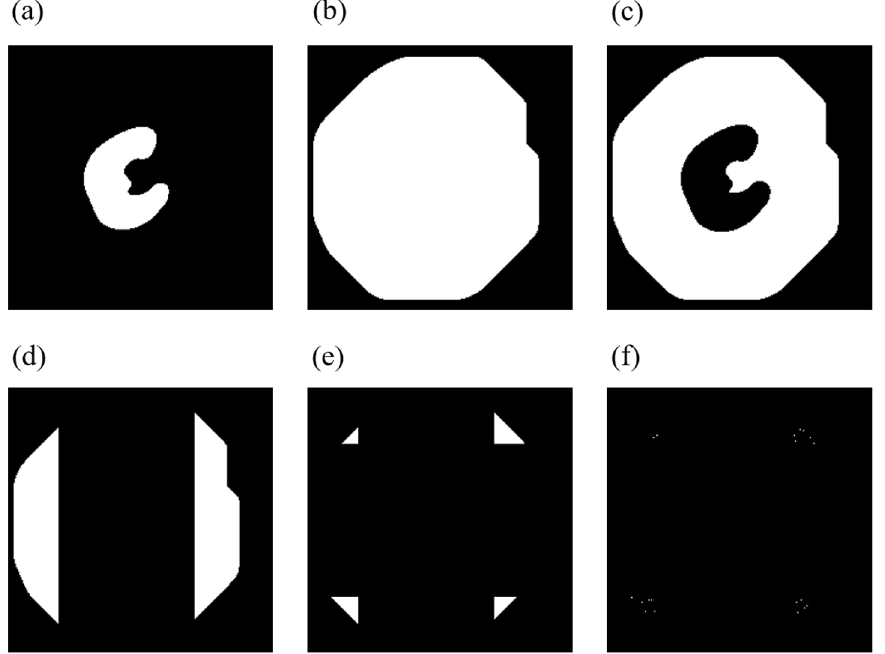
Figure 7. The process of generating points for the BC class. ( a ) Shows the kidney mask annotated by an expert. ( b ) Displays a mask enlarged with dilation transformation. ( c ) Shows the effect of overlapping and cropping the kidney mask from the image. ( d ) Shows the effect of strip removal on the Y axis. ( e ) Shows the effect of strip removal on the X axis. ( f ) Shows the final generated